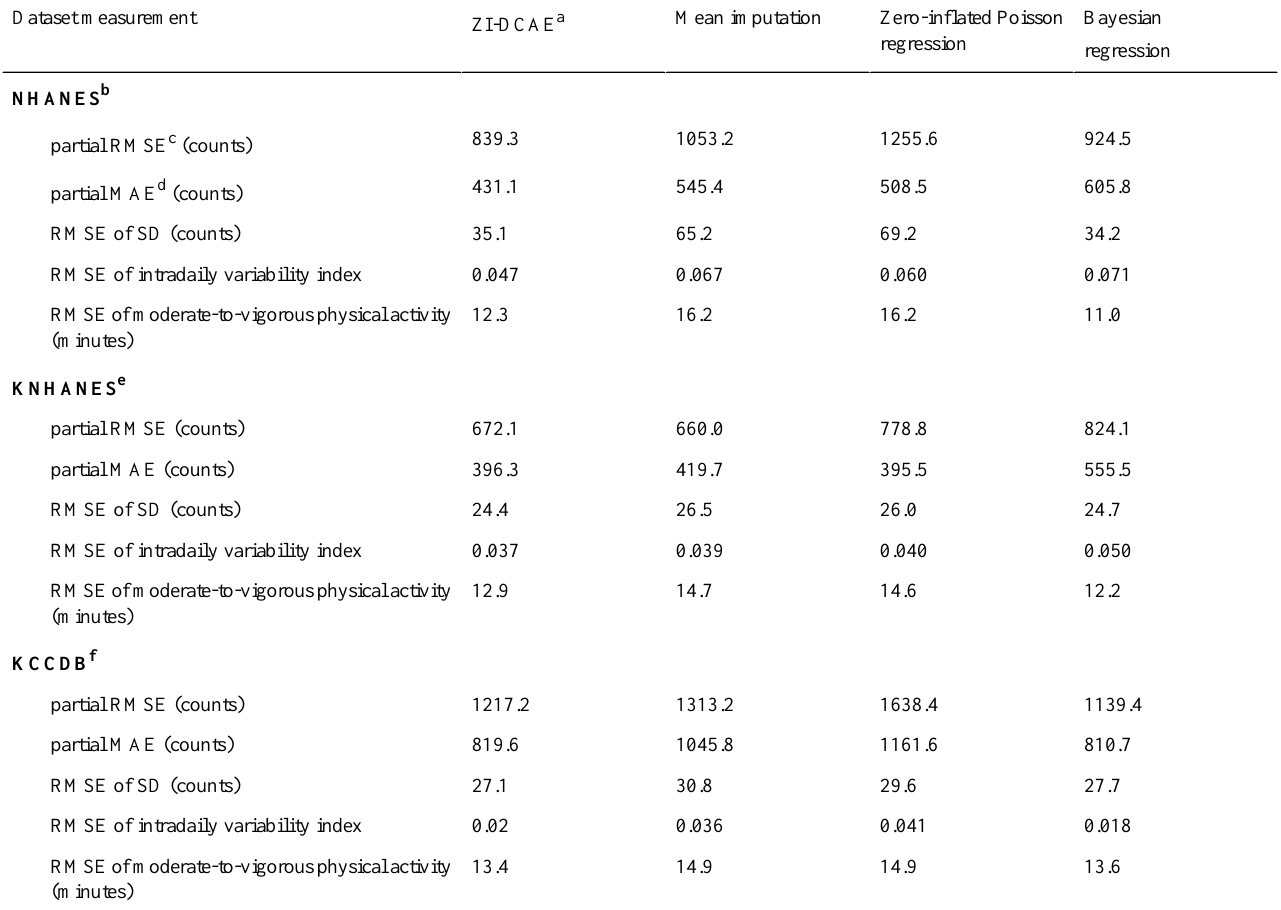
Table 4. Imputation performance results for the comparison